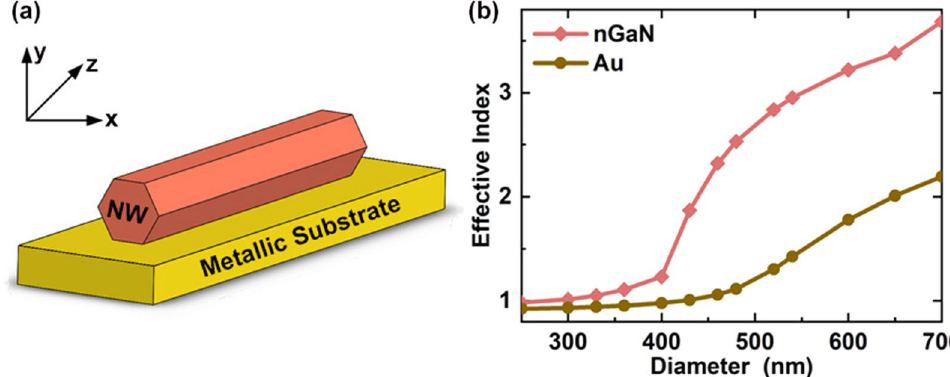
Fig. 2 Schematic structure of plasmonic NW laser a and mode effective index of plasmonic NW lasers